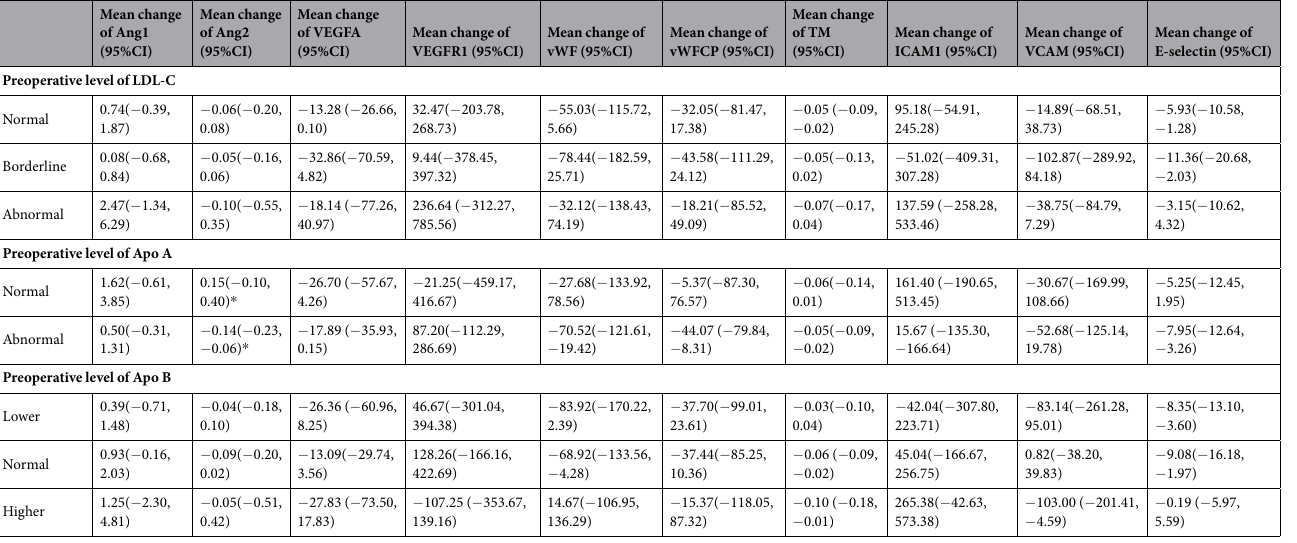
Table 4. Subgroup comparisons of 10 serum markers with the baseline values. Abbreviations: AHI = apnea-